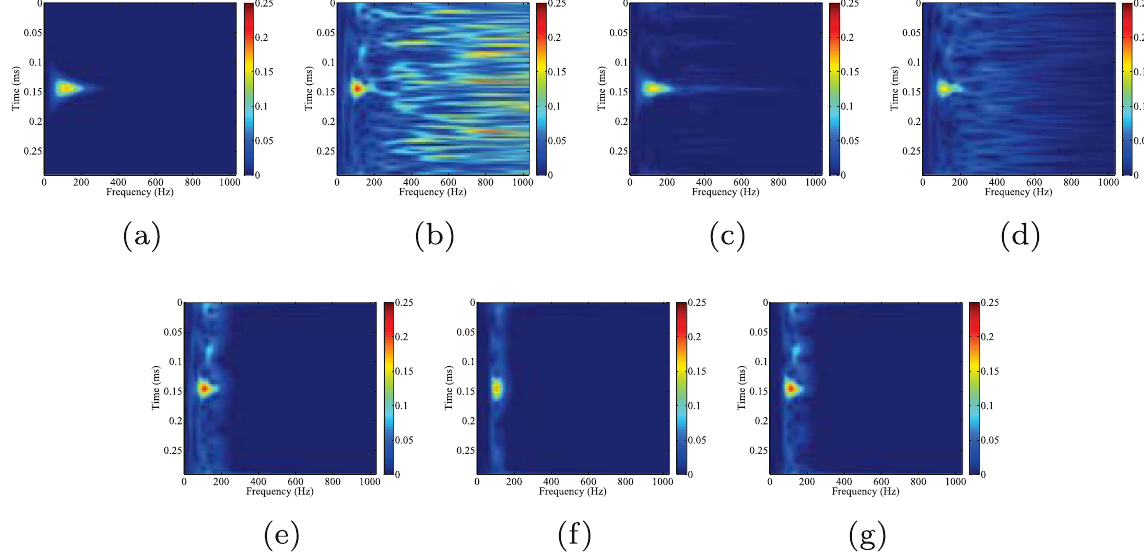
Figure 5. Comparison of time-frequency spectrums of ( a ) clean data, ( b ) noisy data, ( c ) orthogonalized morphological reconstruction, ( d ) conventional morphological reconstruction, ( e ) filtered data